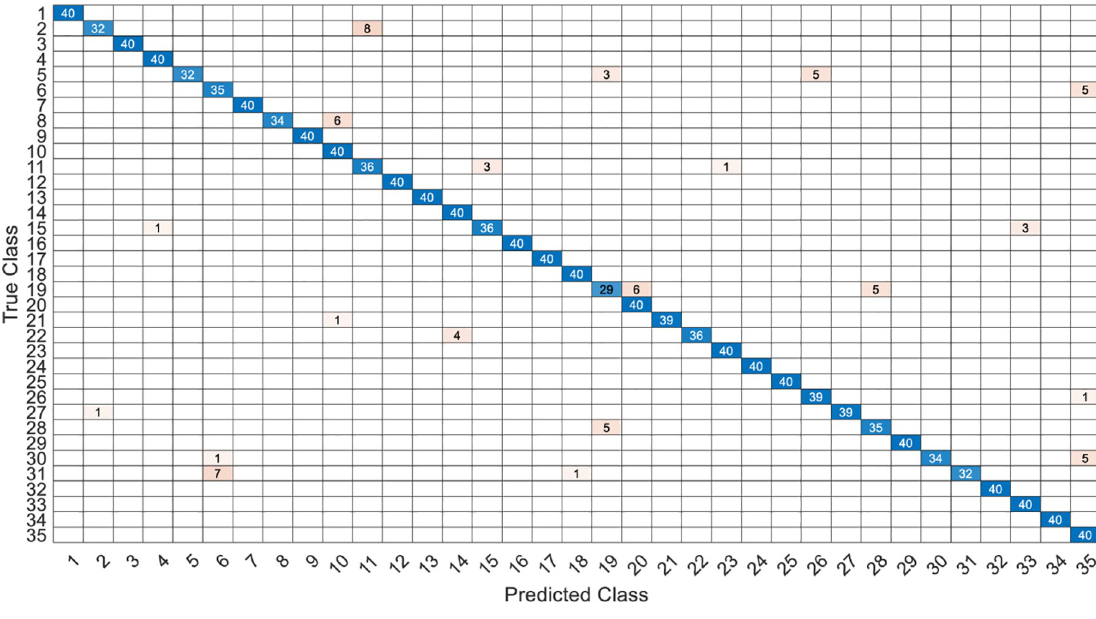
Fig 35. The confusion matrix of LSTM-2 × 200 model with LPC